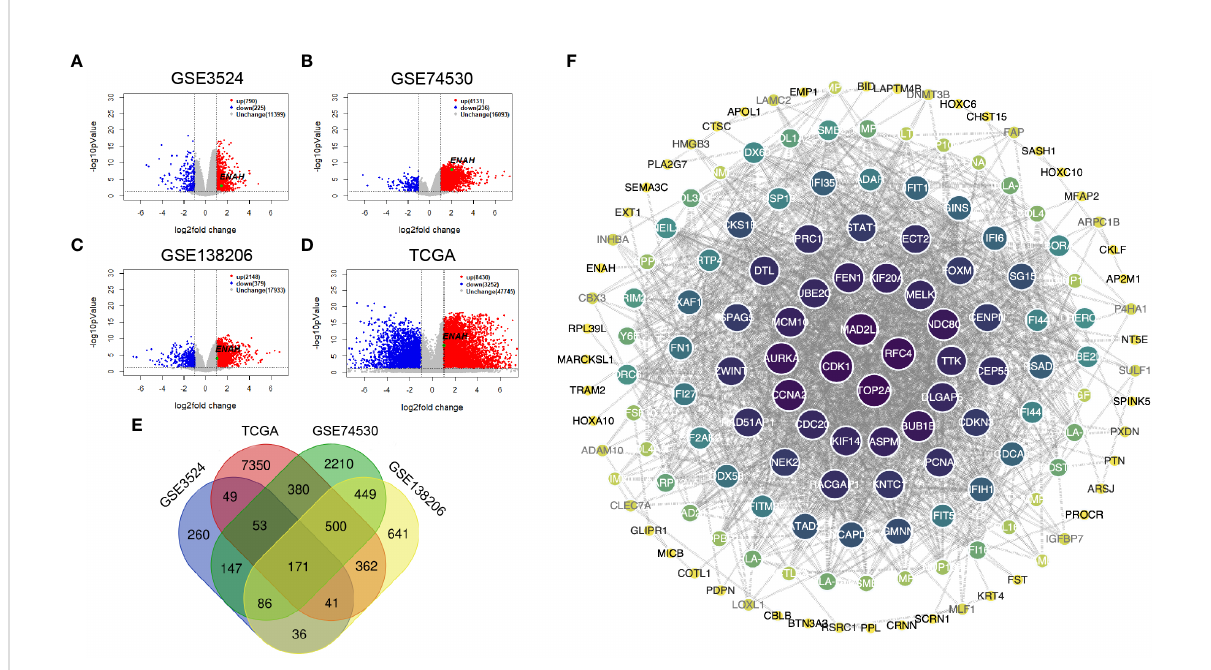
FIGURE 2 The construction and visualization PPI network of Mena based on DEGs from 3 GEO and 1 TCGA databases. (A-D) Volcano plots of DEGs from GSE3524, GSE74530, GSE138206, and OSCC-TCGA. (E) Venn diagram of 171 common DEGs in 3 GEO and 1 TCGA. (F) PPI network visualized by